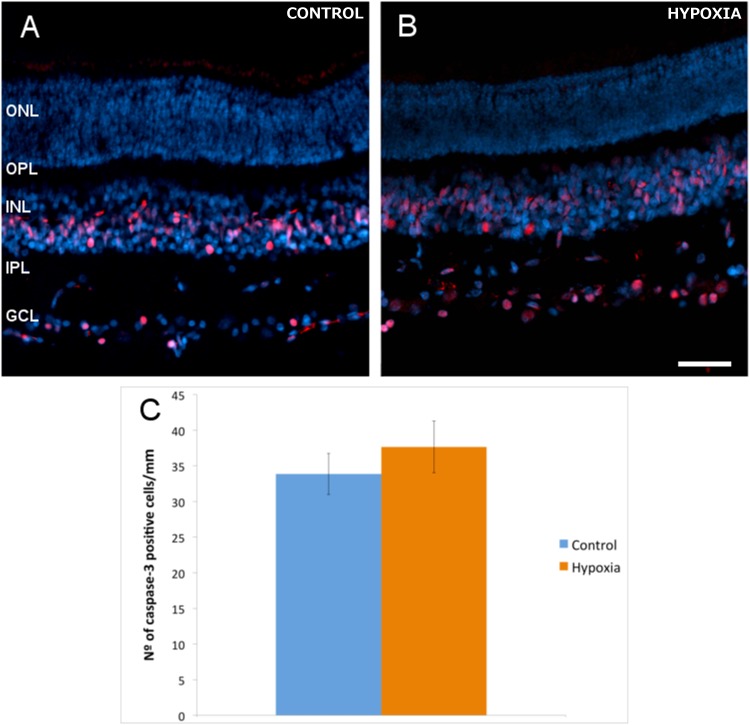
Active caspase-3-positive cells in retinal sections.The nuclei of neurons were labelled with DAPI (blue) and the apoptotic cells with an antibody against active caspase-3 (red) in control (A) and hypoxic (B) retinas. (C) Histogram of the average number of active caspase-3 positive cells per mm of the RGC layer in control and hypoxic retinas. The standard error of the mean is represented as an error bar: ONL, outer nuclear layer; OPL, outer plexiform layer; INL, inner nuclear layer; IPL, inner nuclear layer; GCL, ganglion cell layer. Scale bar = 50 μm.